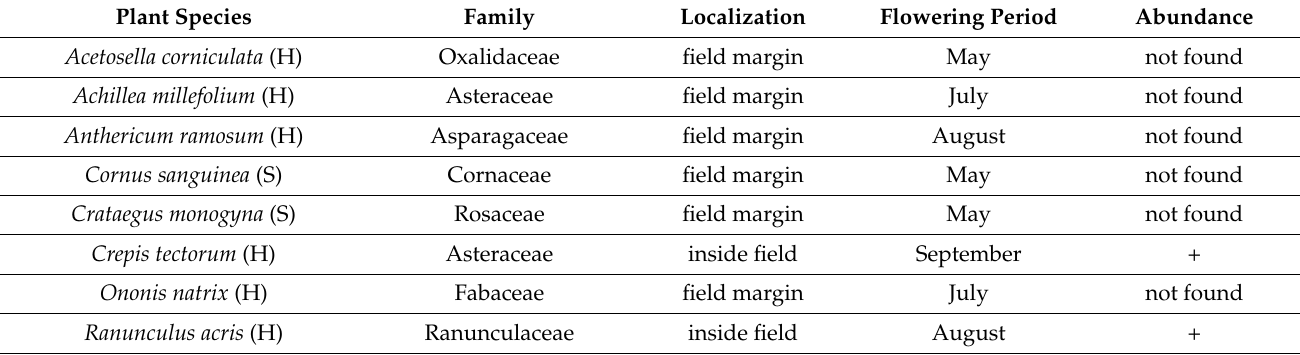
Figure 2. ( a ) Adult of SBW on Taraxacum sp. flower (Tonina©); ( b ) Taraxacum sp. pollen grains in the insect gut; ovaries (red arrow) were still immature at the end of April 2019 (stereo microscope photo: Grassi©). Table 2. Herbaceous (H) and shrub (S) flowering species investigated in and around the strawberry field. Abundance of SBW adults: + rarely, ++ frequently, and +++